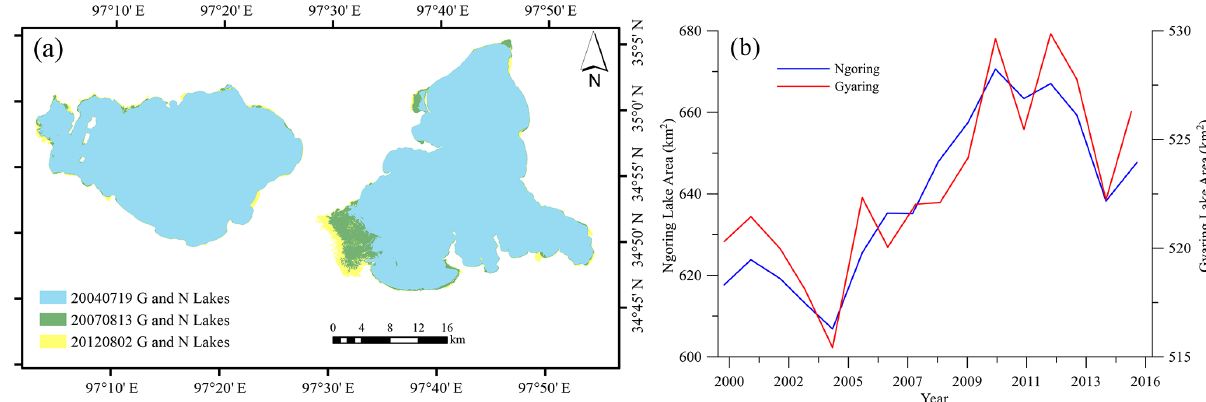
Figure 6. Lakes expansion and area change shown in panels (a) and (b) , respectively.